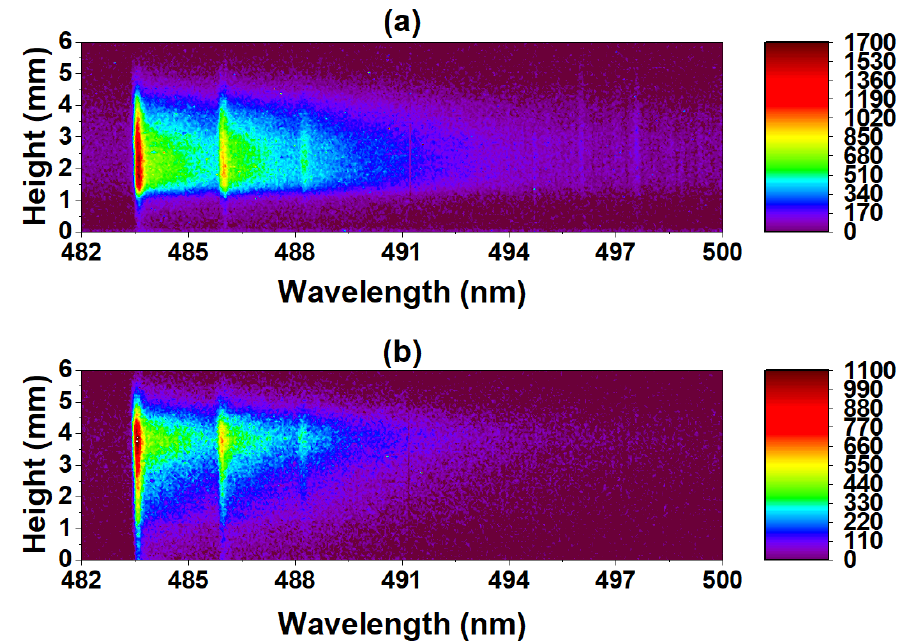
Figure 1. Contour mappings of spatially resolved AlO spectral measurements along the plasma plume height measured at ( a ) 20 µ s and ( b ) 35 µ s time